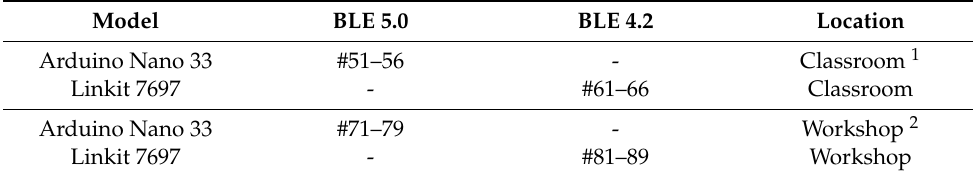
Table 4. Components numbering (BLE 5.0 and BLE 4.2).